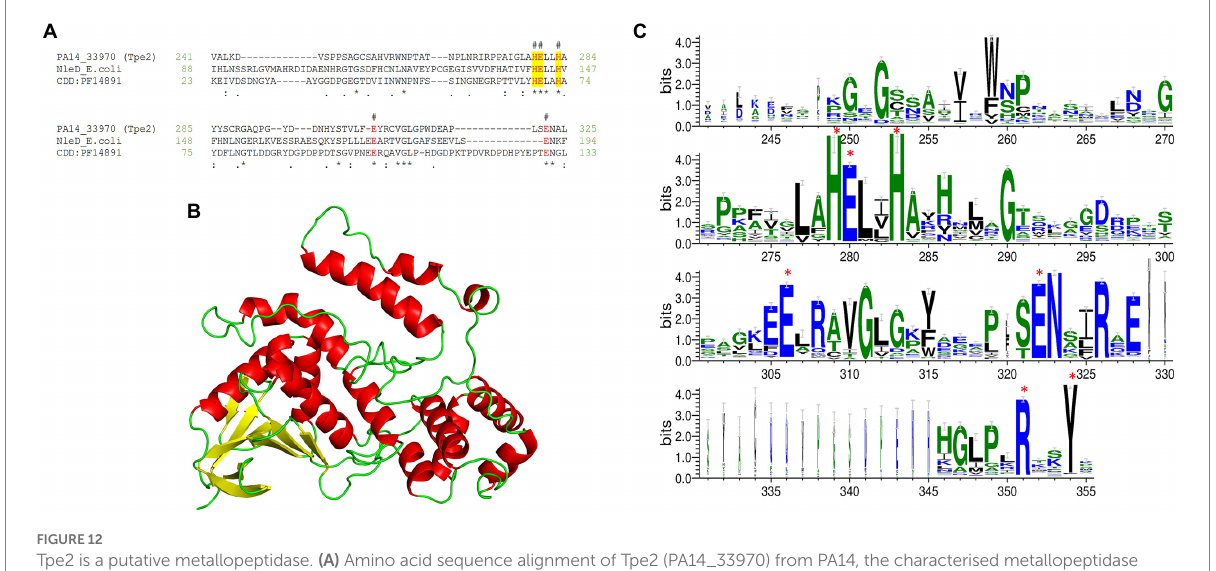
FIGURE 12 Tpe2 is a putative metallopeptidase. (A) Amino acid sequence alignment of Tpe2 (PA14_33970) from PA14, the characterised metallopeptidase NleD from E. coli (WP_247157463.1) and the consensus sequence of the peptidase M91 domain (NCBI-CDD domain PF14891) highlight the conservation of the metallopeptidase HExxH motif (highlighted yellow) and amino acids E261 and E350 conserved within BoNT neurotoxins as identified in Mansfield et al. (in red and labelled with #; Mansfield et al., 2019). (B) Alphafold (Jumper et al., 2021; Varadi et al., 2022) predicted model of Tpe2 visualised using PyMOL (The PyMOL Molecular Graphics System, Version 2.5.4, Schrödinger, LLC). (C) WebLogo3 diagram showing the most frequent residues found in homologs of Tpe2 from a PSSM approach. Conserved residues from the Botulinum neurotoxin metalloproteases family are labelled with a red